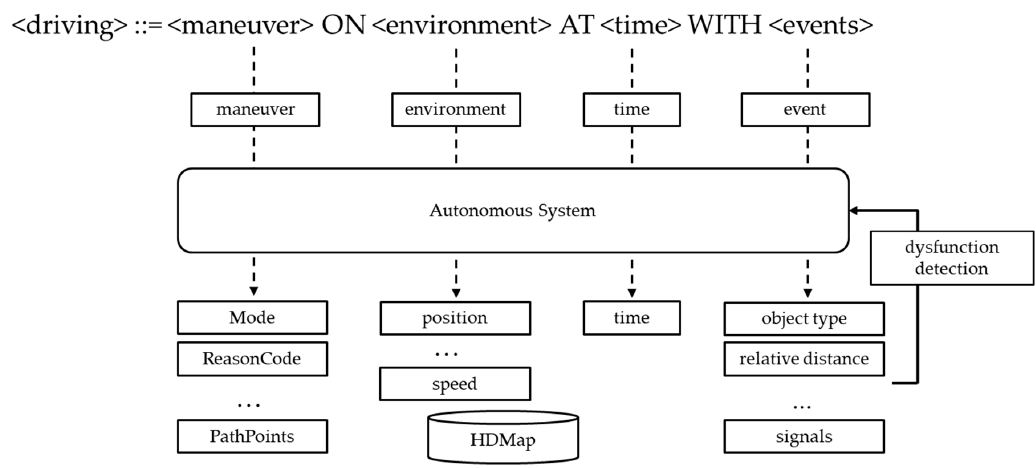
Figure 8. Summary of driving data logging items.